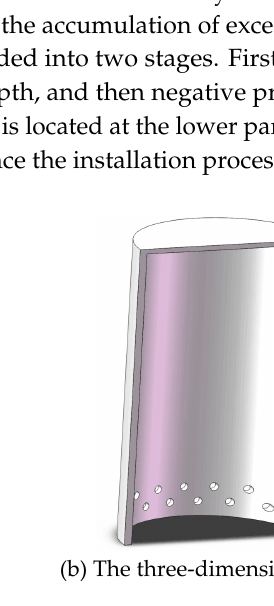
Figure 15. The perforated suction anchor